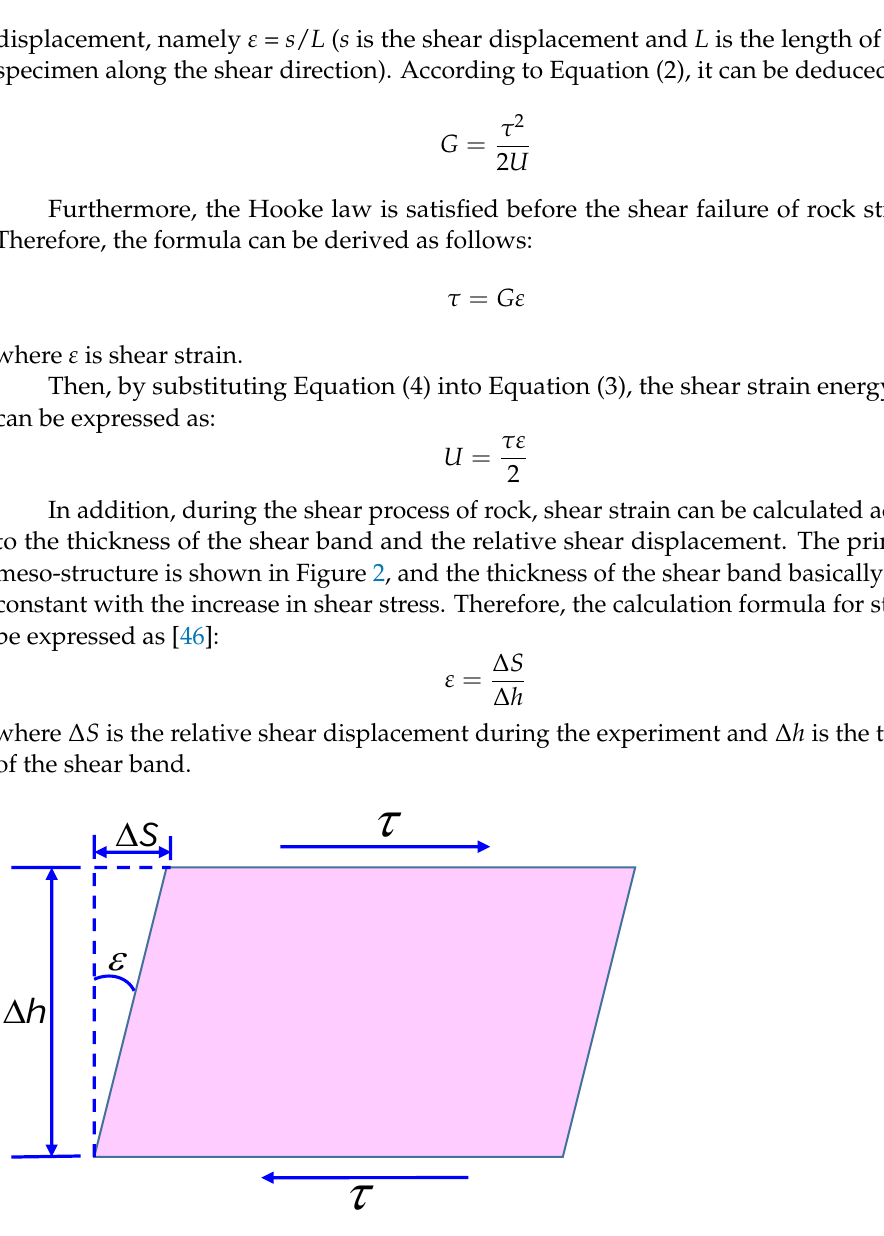
Figure 2. Schematic diagram showing the force analysis of rock shear zone [45]. Therefore, according to the freeze–thaw shear experimental results in Lei [44], and combined with Equations (3)–(5), the shear modulus of rock specimens under different freeze–thaw cycles can be calculated, shown in Table 1. Table 1. Variation characteristics of the shear modulus with the freeze–thaw cycles. Specimen